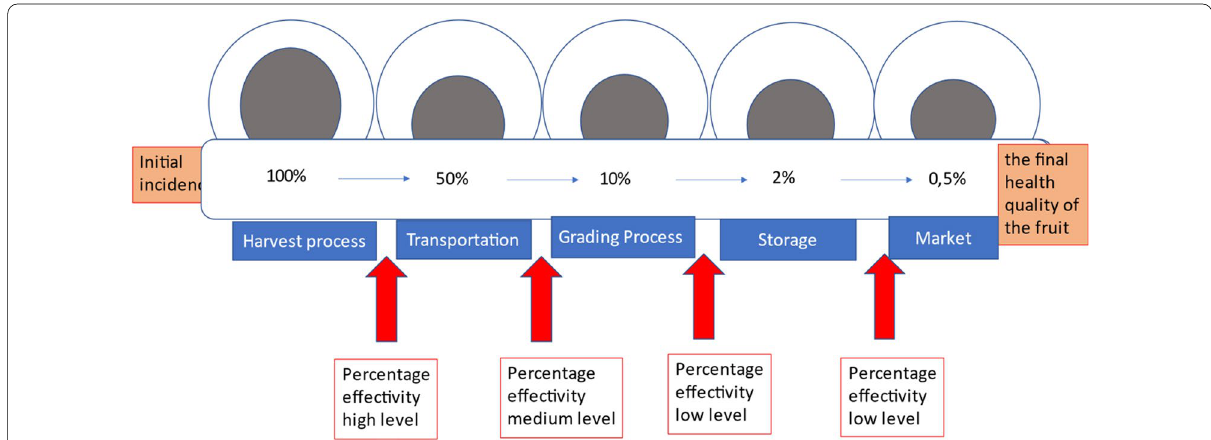
Fig. 1 Overview of assumption of strategy effectiveness of postharvest diseases control for citrus and subtropical fruits in combination and